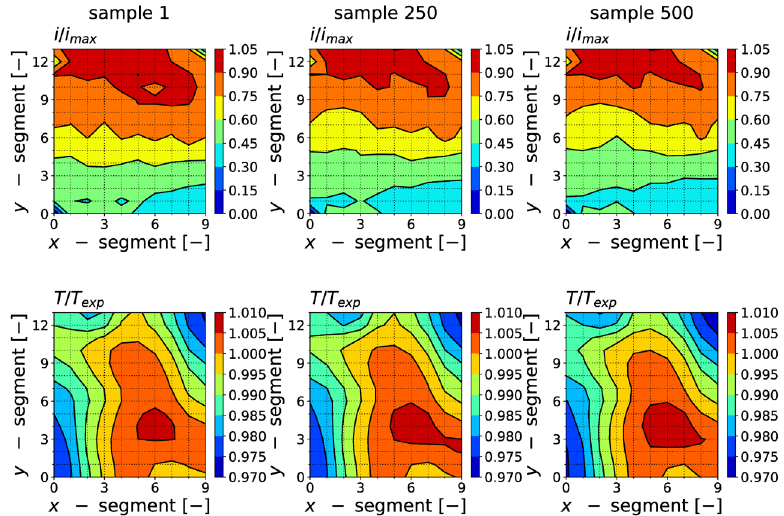
Fig. A4. Distribution of the current density and temperature at maximal load in the AST -